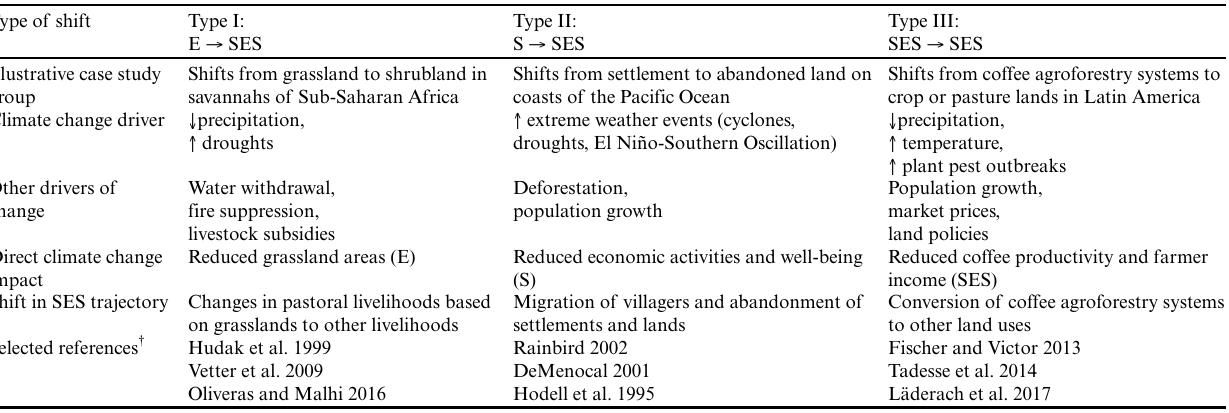
Table 2. Illustrative examples of case studies for each of the three types (Type I–III) of shifts in social-ecological systems driven by climate change. Climate change and other drivers directly impact part of the system (either ecological [E], social [S], or social-ecological system [SES]), leading to responses that shift the trajectory of the entire social-ecological system.